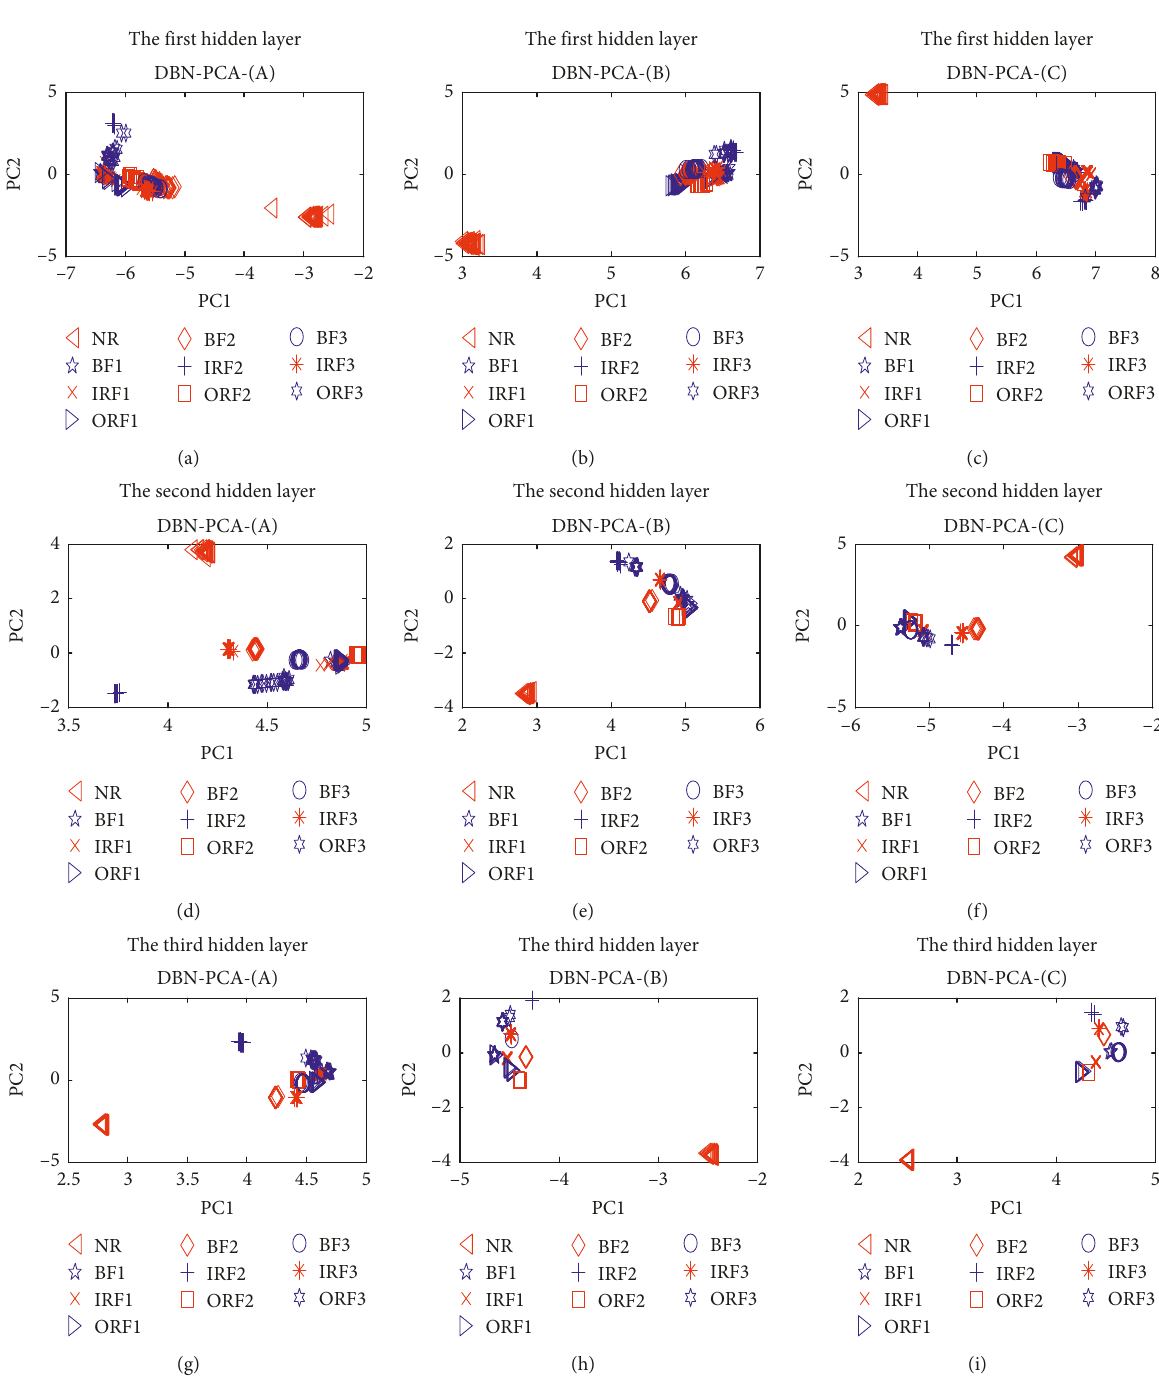
Figure 7: The PC1 and PC2 obtained by each hidden layer in DBN: (a, d, g) dataset A; (b, e, h) dataset B; (c, f, i) dataset